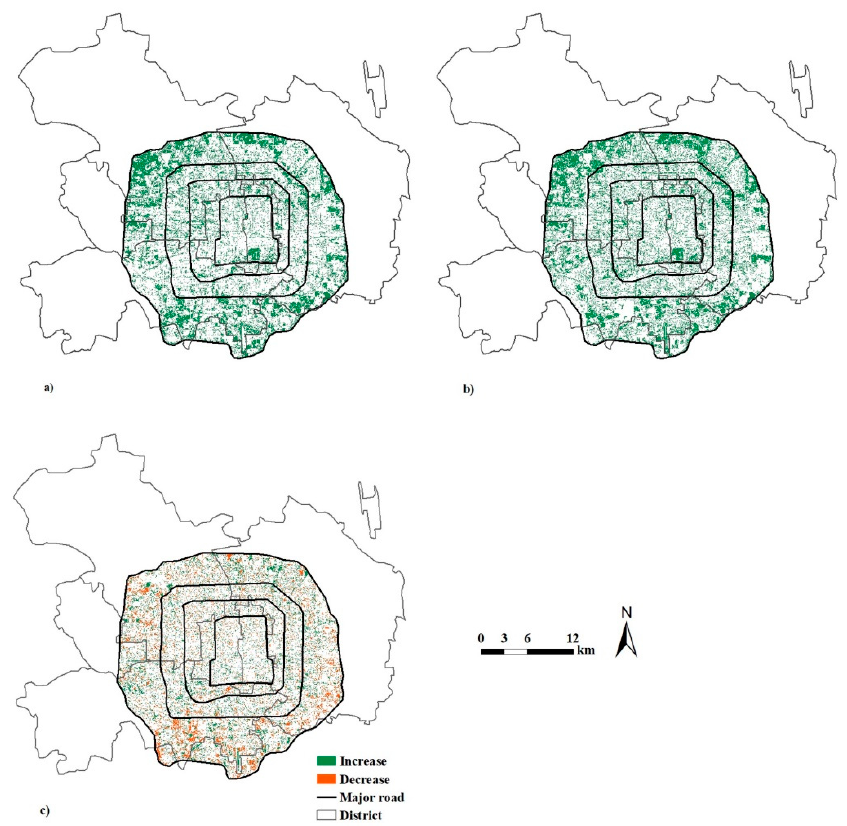
Figure 3. Greenspace in 2005 and 2015, and its change. ( a ) Greenspace in 2005; ( b ) Greenspace in 2015; ( c ) Greenspace change from 2005–2015.